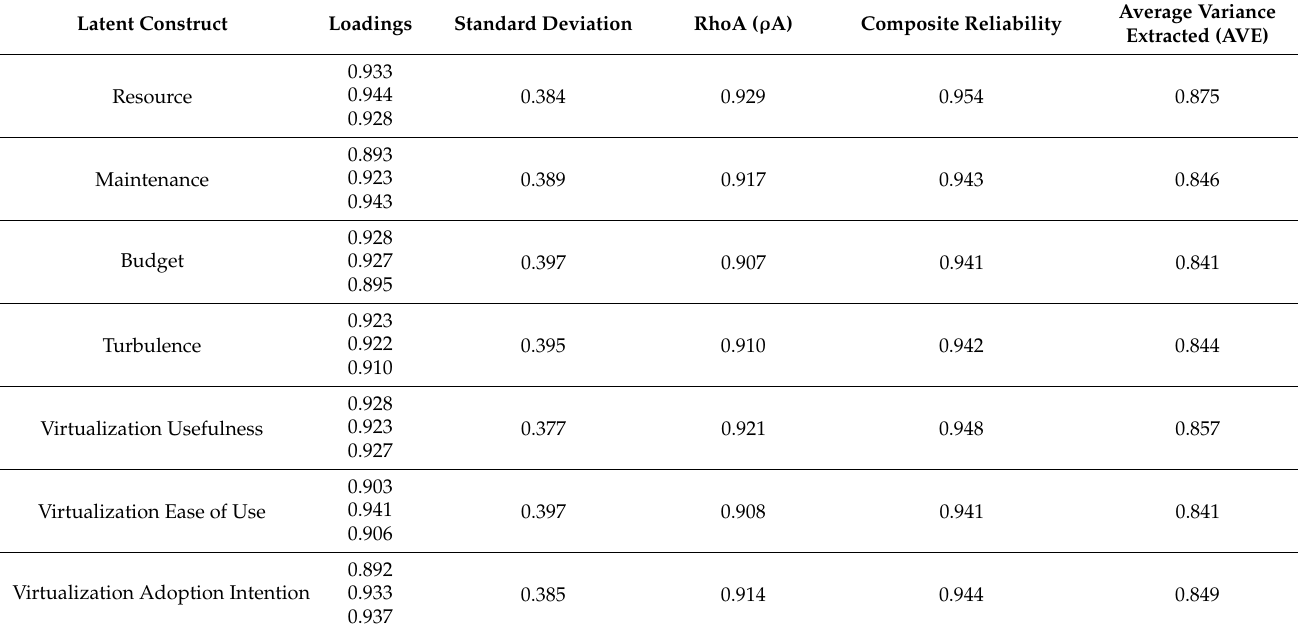
Table 2. Convergent Validity and Construct Reliability.